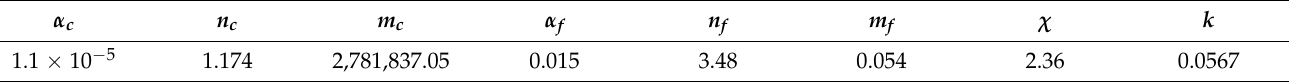
Table 1. The fitting parameters for the model.